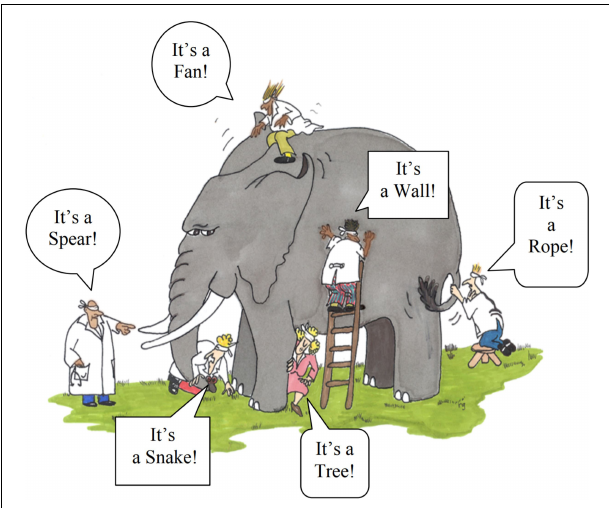
FIGURE 1 | Blind people “seeing” the elephant (reproduced with permission from Himmelfarb et al., 2002).